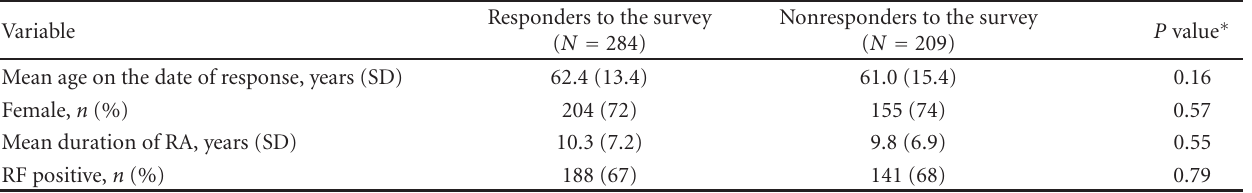
Table 2: Demographics and RA characteristics in survey responders and nonresponders to the survey among patients with rheumatoid arthritis.